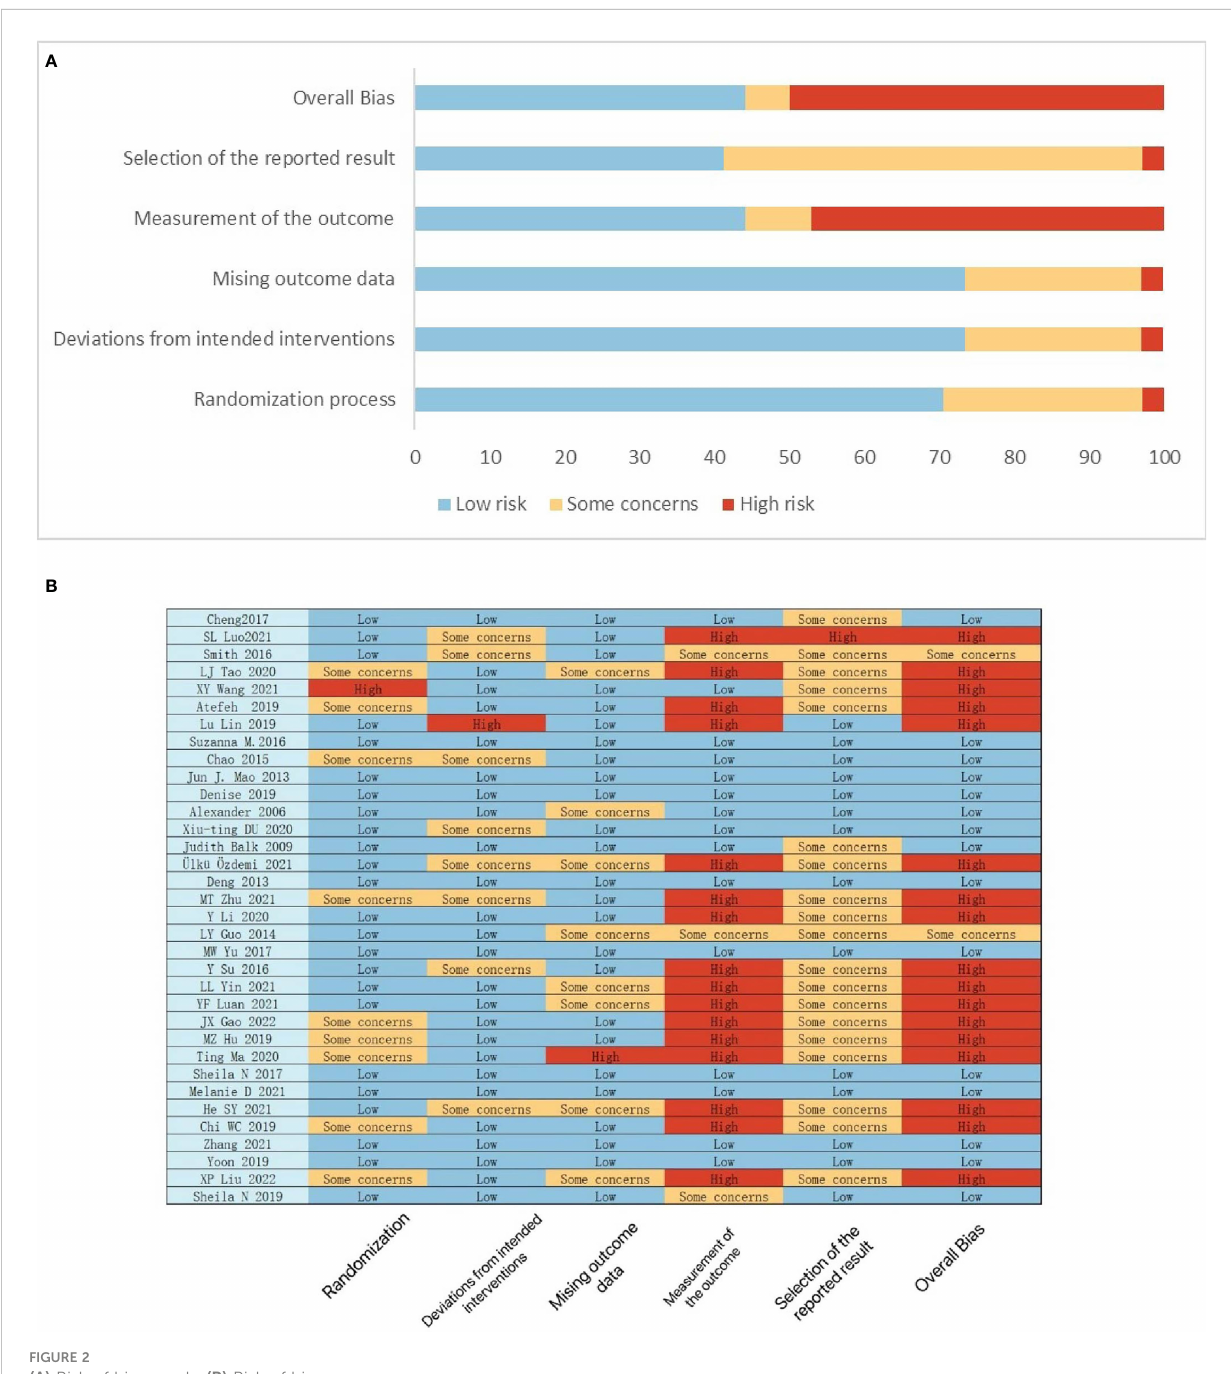
FIGURE 2 (A) Risk of bias graph; (B) Risk of bias